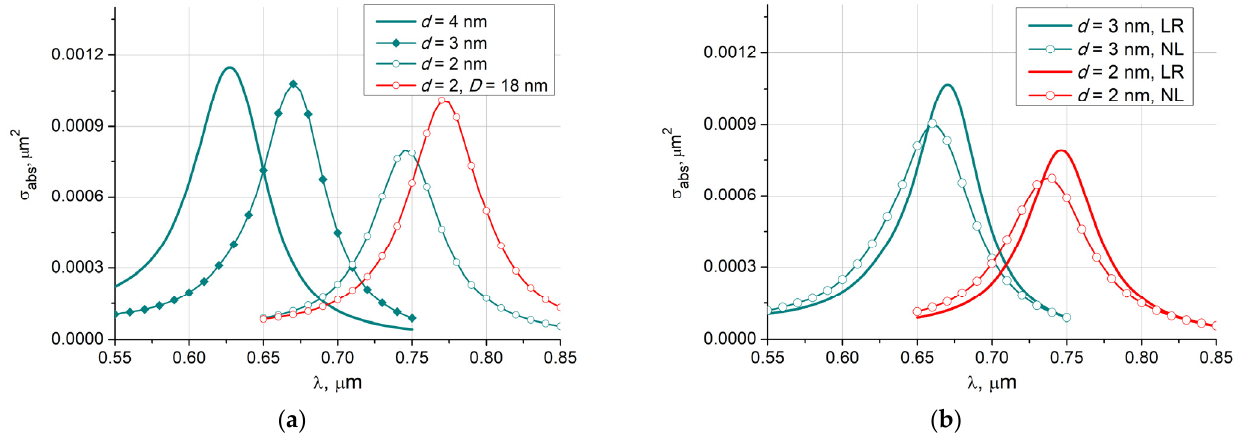
Figure 2. Absorption cross-section versus the exciting wavelength for spherical core-shell Fe 3 O 4 @Au particle with core diameter D = 16 nm: ( a ) different shell thicknesses d ; ( b ) local response (LR), and non-local response (NL) results.